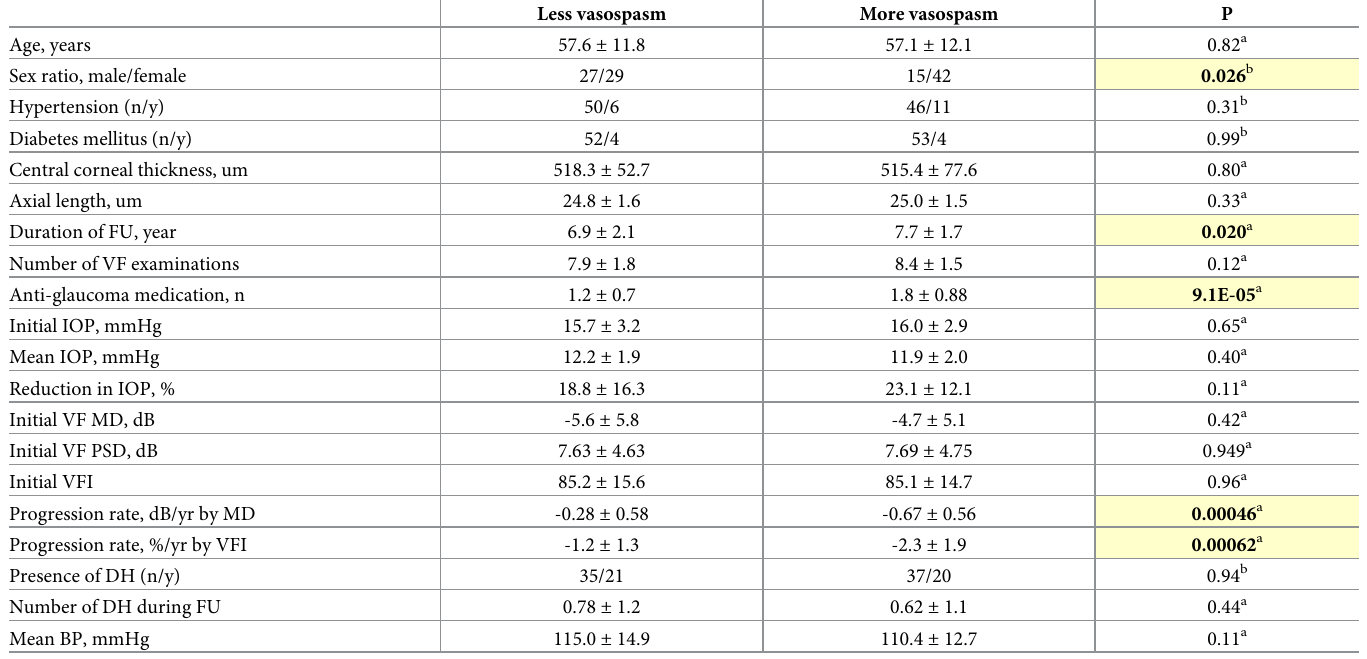
Table 3. Comparison of clinical characteristics and VF progression rates according to the degree of peripheral